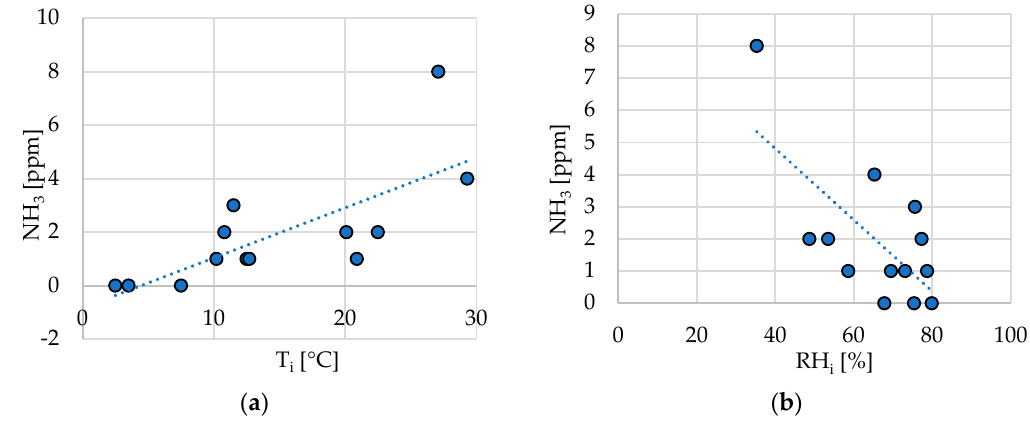
Figure 10. Correlation diagrams between NH 3 concentration in the pre-RDF storage section of biogas plant A and measured microclimatic parameters, with regression lines: ( a ) R 2 = 0.54, ( b ) R 2 = 0.47.